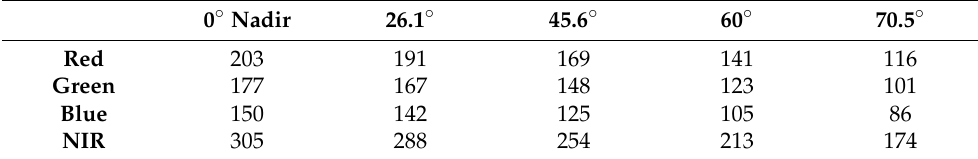
Table 9. SNR analysis